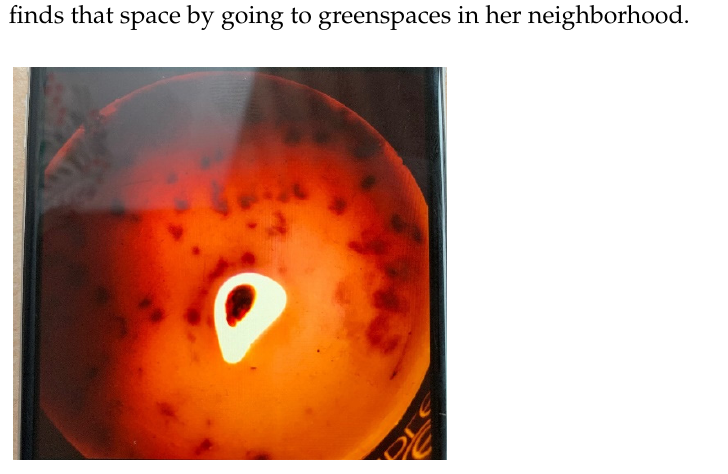
Figure 5. A lit candle, shown from above.